Question: Compose a caption that would accompany this figure in a paper.
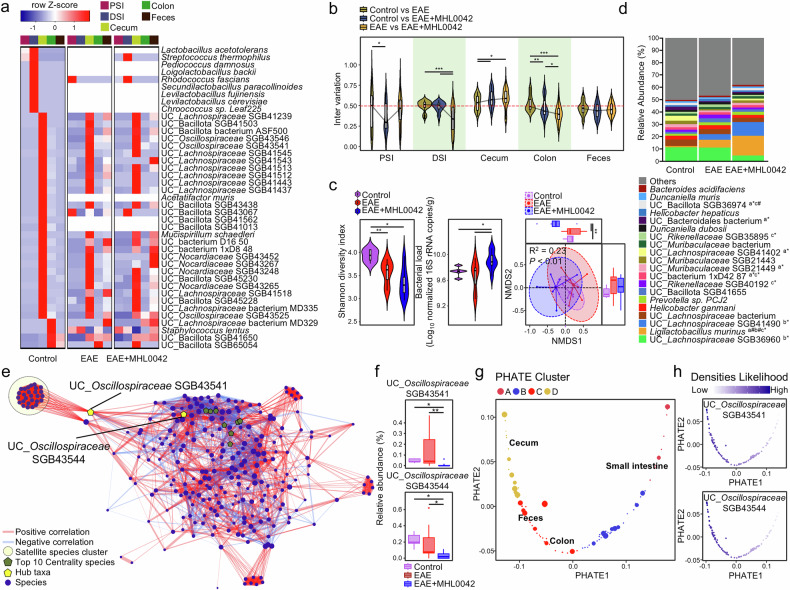
Answer: Gut microbiota comparisons across gastrointestinal tract regions in the three groups. a Indicator species defined in control mice were compared across groups based on the gastrointestinal (GI) region. b Bray–Curtis dissimilarity was used to assess intergroup differences in each GI region. Significance was tested using Dunn′s test with false discovery rate correction. c Cecal microbial diversity and total bacterial load were compared among the groups. Non-metric multidimensional scale (NMDS) based on Bray–Curtis dissimilarity visualizes species-level composition. PERMANOVA and Dunn's test (false discovery rate correction) were used for statistical comparisons. d Relative abundance of dominant species in the cecal microbiota. Bars show group means; species <1% mean abundance were grouped as “Others”. MaAsLiN2 was used for significance testing. Comparisons: control versus EAE (part a ); control versus EAE + Veillonella ratti MHL0042 (part b ); EAE versus EAE + V. ratti MHL0042 (part c ). * P < 0.05; # q < 0.05. e Network of cecal microbiota in the EAE + V. ratti MHL0042 group. Edges: significant Spearman correlations (| ρ |> 0.7, P < 0.05); red: positive, blue: negative; thickness: correlation strength. Node size: PageRank centrality. Green pentagons: top 10 central species; yellow: downregulated network hub taxa; dashed circles: associated satellite. f Relative abundance of selected network hub taxa across treatment groups. Statistical differences in relative abundance were assessed using MaAsLin2 to evaluate group-specific enrichment. * P < 0.05; ** P < 0.005. g Multiscale potential of heat diffusion for affinity-based transition embedding (PHATE) showing microbiota clustering across GI regions. Labels A–D indicate that four clusters denote PHATE diffusion–condensation cluster. h Manifold density estimation (MELD) likelihoods visualization of network hub taxa density on PHATE embedding. DSI, distal small intestine; EAE, experimental autoimmune encephalomyelitis; PSI,